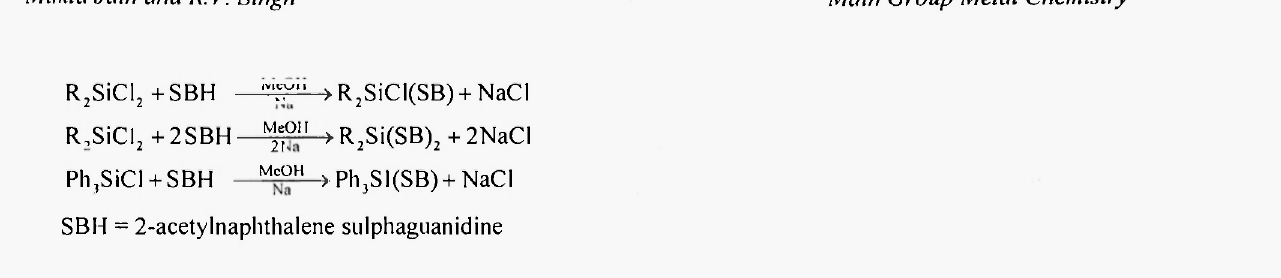
Characteristic Properties of the Ligand and its Silicon